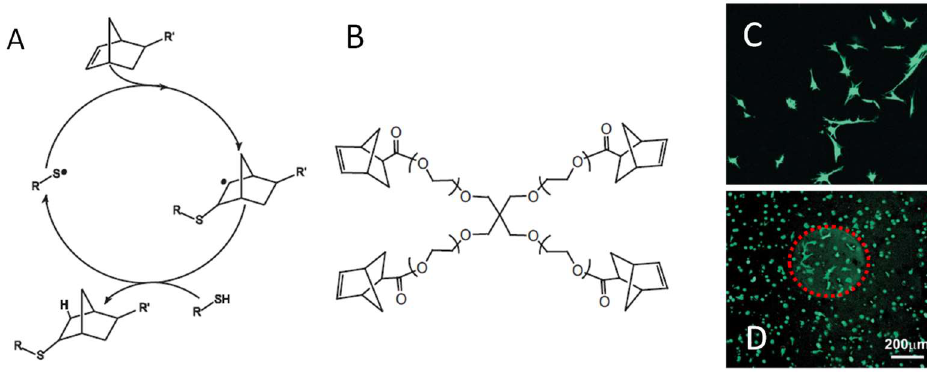
Figure 17. ( A ) A general mechanism of radical-mediated thiol-norbornene addition. ( B ) Four-armed norbornene-presenting PEG macromonomers were used to crosslink with di-cysteine-terminated peptides to form hydrogels. The gel can be modified uniformly with a cell adhesion peptide CRGDS during crosslinking ( C ) or after gelation through unreacted norborenene at defined locations shown as the red sphere in ( D ), both supporting cell attachment and spreading. Images reproduced with permission from [92]. Copyright 2009 Wiley.